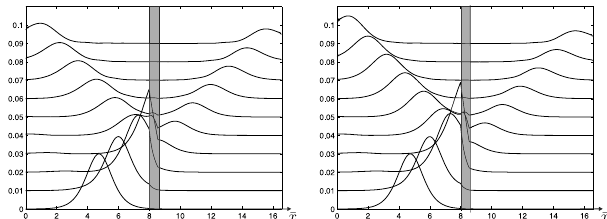
Fig. 5. Surface elevation ¯ η( ¯ x, ¯ t) at subsequent times t 0 = 0 < t 1 < ... < t 10 = 7s. Every following curve is shifted upwards to give a 3-dimensional impression. Left: K 1 = 0 . 95, K 2 = 1, K 3 =0.95cms − 1 , right: K 1 = 0 . 7, K 2 = 0 . 75, K 3 =0.7cms − 1 . All three layers are of the same thicknesses.